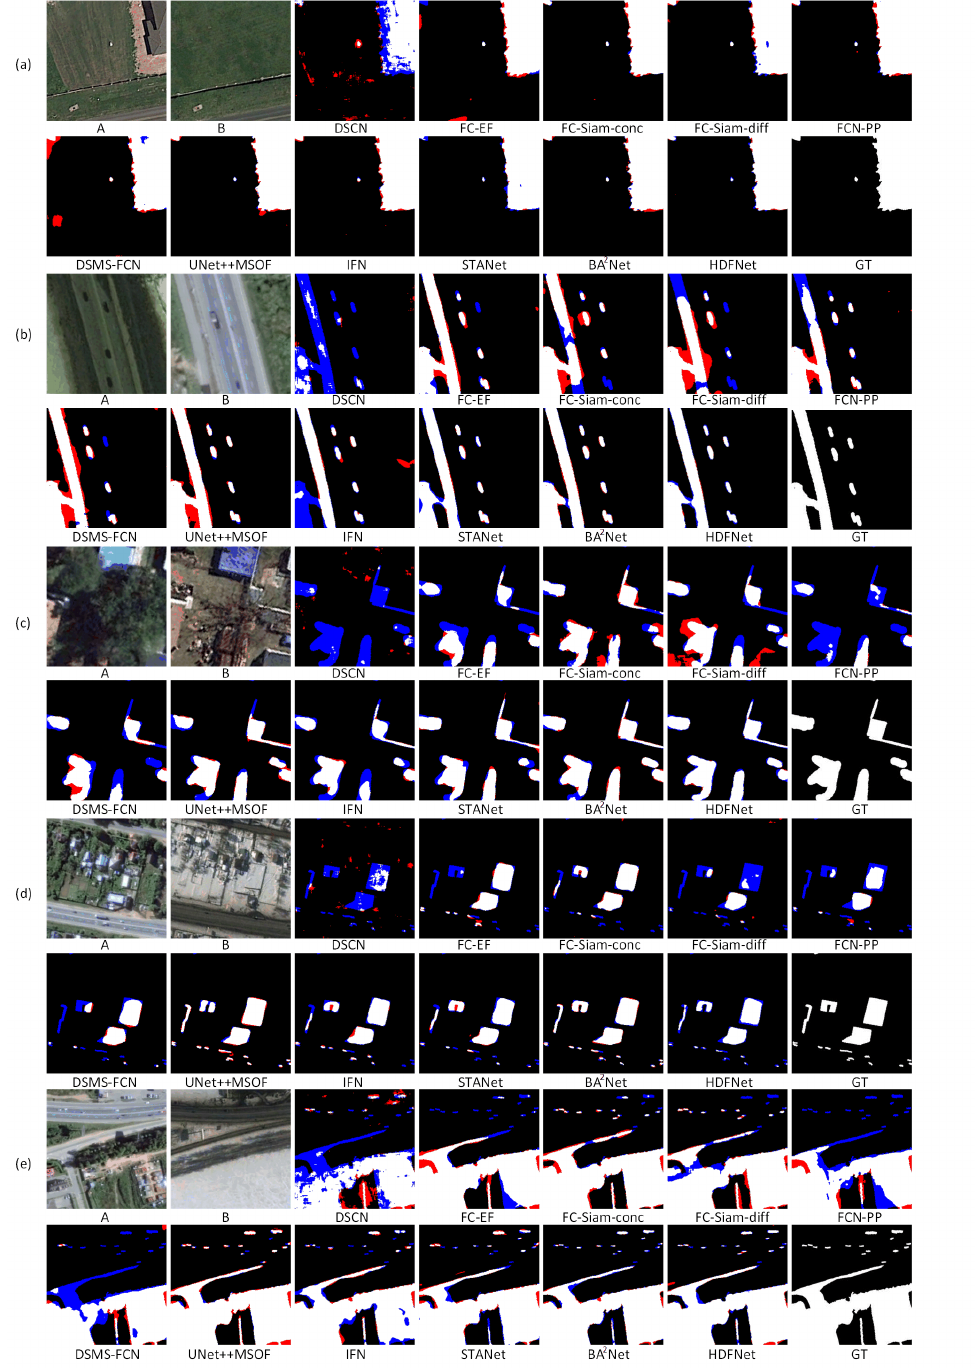
Figure 6. Illustration of qualitative comparison on dataset LEBEDEV. The ( a – e ) indicate samples from LEBEDEV and the change maps obtained by different methods. White indicates the changes detected correctly. Black indicates the no change detected correctly. Red indicates the false alarms. Blue indicates unpredicted